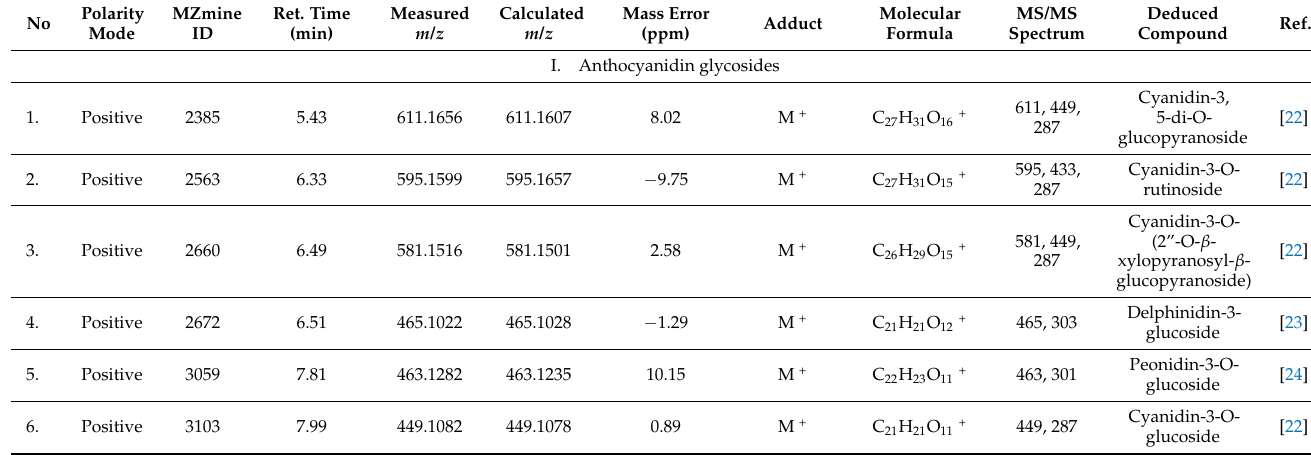
Table 1. Metabolic profiling of the crude extract of S . cornutus using LC-MS/MS